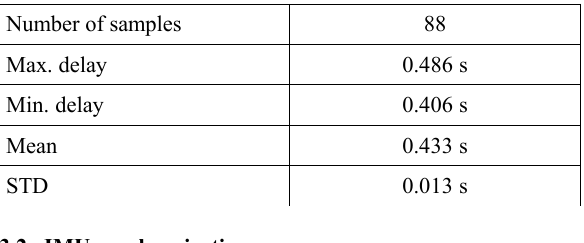
Table 3. Camera-lag statistics in a manual mode.